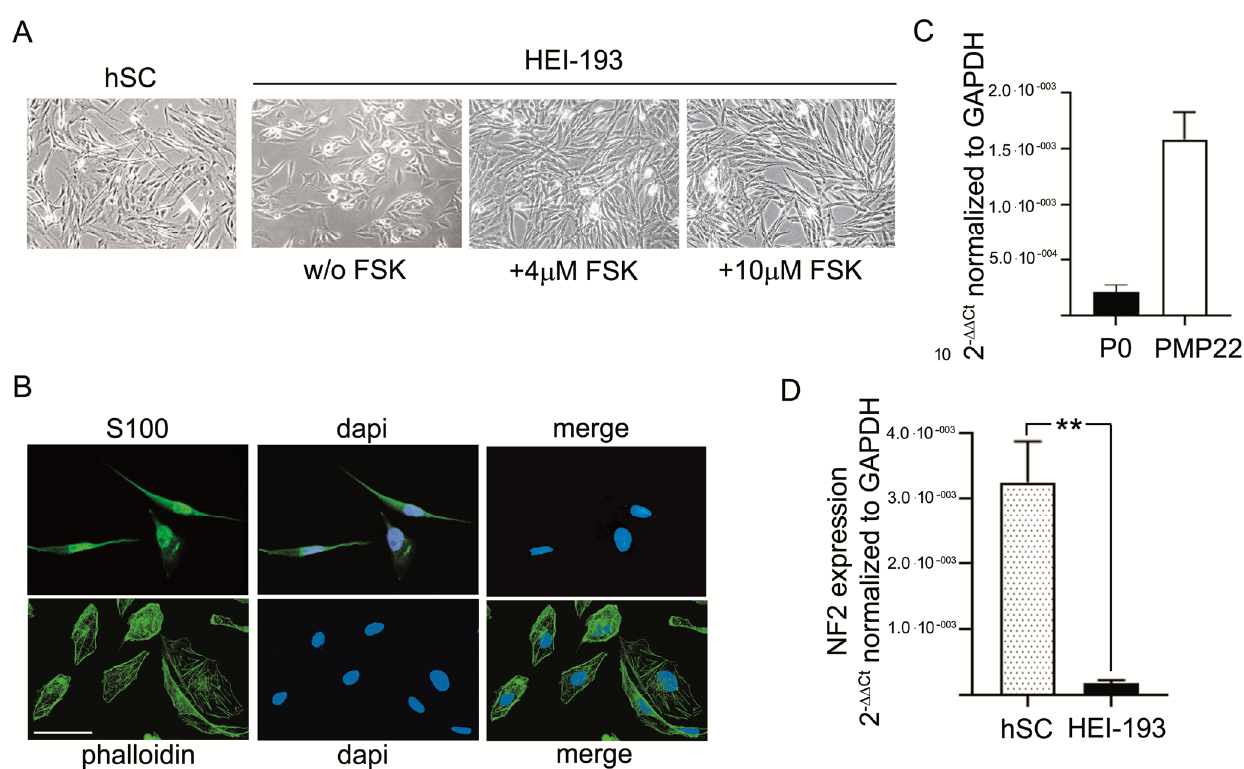
Figure 1. Characterization of HEI-193 cells. ( A ) Representative phase-contrast images of primary human SCs (hSC) and HEI-193 cells in culture at 7 div (day in vitro), following treatment with 4 and 10 µ M forskolin (fsk). Scale bar 10 µ m. ( B ) IFL microscopy images of HEI-193 characterized by immunopositivity for the S100 marker (anti-s100-488, in green), showing a cell purity more than 98%. Cells were typically spindle-shaped. The actin cytoskeleton was assessed by labelling for f-actin (phalloidin-FITC, in green). Nuclei were stained with Dapi, in blue. Scale bar 10 µ m. ( C ) Relative quantification by qRT-PCR of mRNAs levels, coding for proteins P0 and PMP22, respectively, in HEI-193 cells. Data were normalized to the housekeeping gene GAPDH and expressed as 2 − ∆∆ Ct . The columns were expressed as fold changes. The values are means ± S.D. ( n = 4). ( D ) Merlin (NF2) mRNA levels were assayed by qRT-PCR, showing a significant decrease (** p < 0.01) in HEI-193 cells versus hSCs. Data were normalized to the housekeeping gene GAPDH and expressed as 2 − ∆∆ Ct . The columns were expressed as fold changes. The values are means ± S.D. ( n =